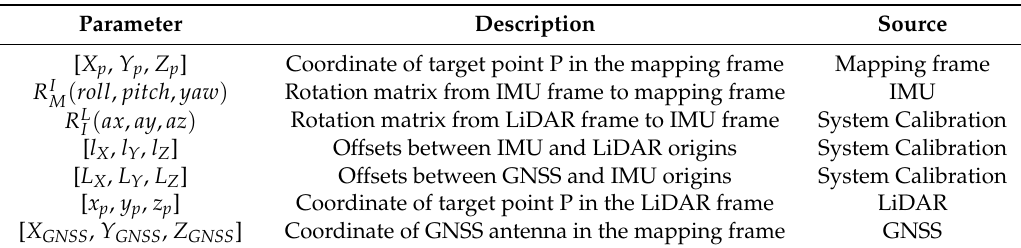
Table 1. Specific parameter description.